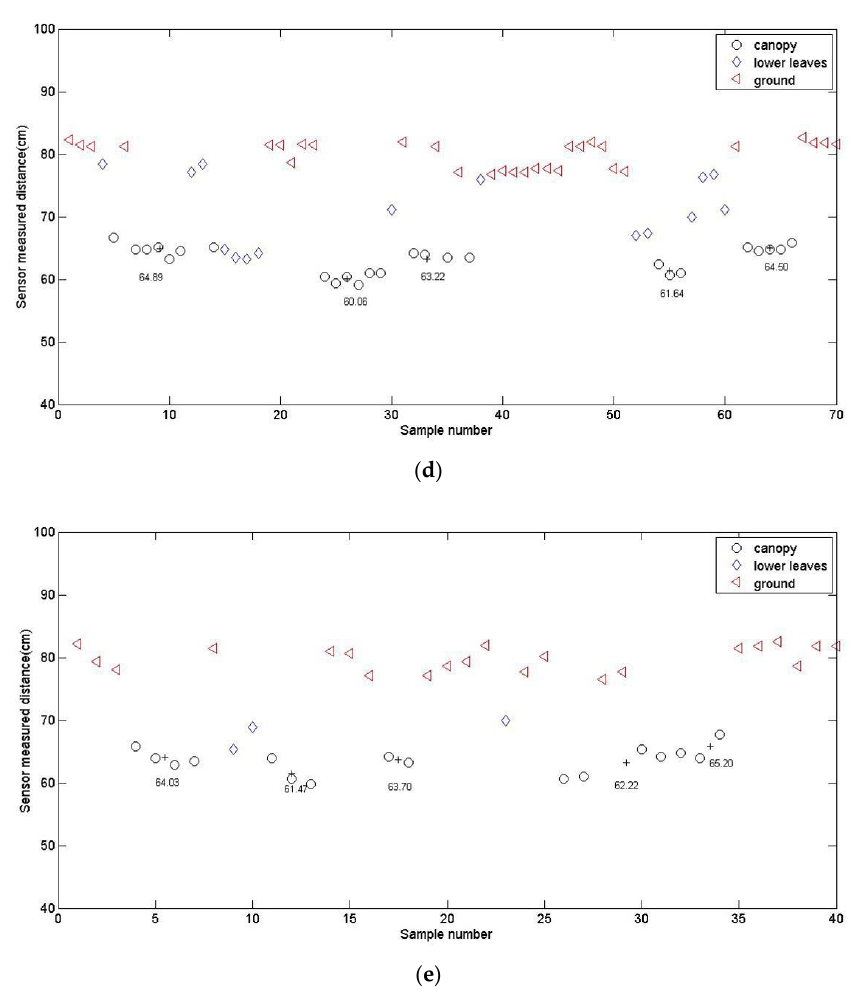
Figure 4. Clustering results for corn plants at the 4-leaf stage at di ff erent speeds: ( a ) v = 0.5 km / h; ( b ) v = 1 km / h; ( c ) v = 2 km / h; ( d ) v = 4 km / h; ( e ) v = 6 km / h. Table 4. Calculated and manually measured values of distance from the sensor to the canopy at di ff erent sensor moving speeds. Plant Number